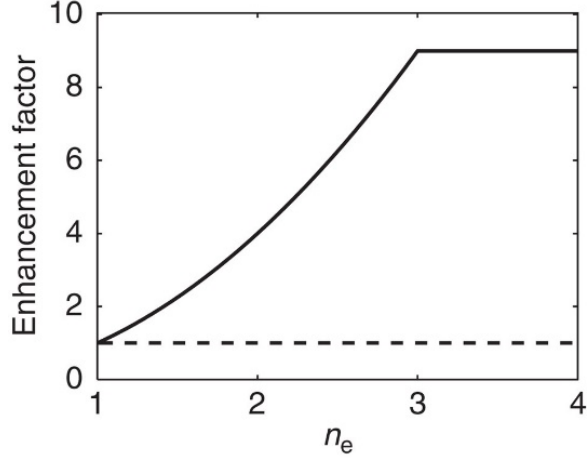
Figure 2: Schematic and actual demonstration of thermal extraction. (a) Emitter formed by an open area (dark red surface) of an absorp- tive cavity. The cavity can be filled with a transparent dielectric of refractive index n i . (b) Thermal extraction using a hemispherical dome placed at the opening of the cavity. The dome is transparent and does not emit or absorb any thermal radiations, and has a re- fractive index n e . Emission cone (white) of the thermal radiation inside the dome is shown. (c, d) [8] Experiment set-up.